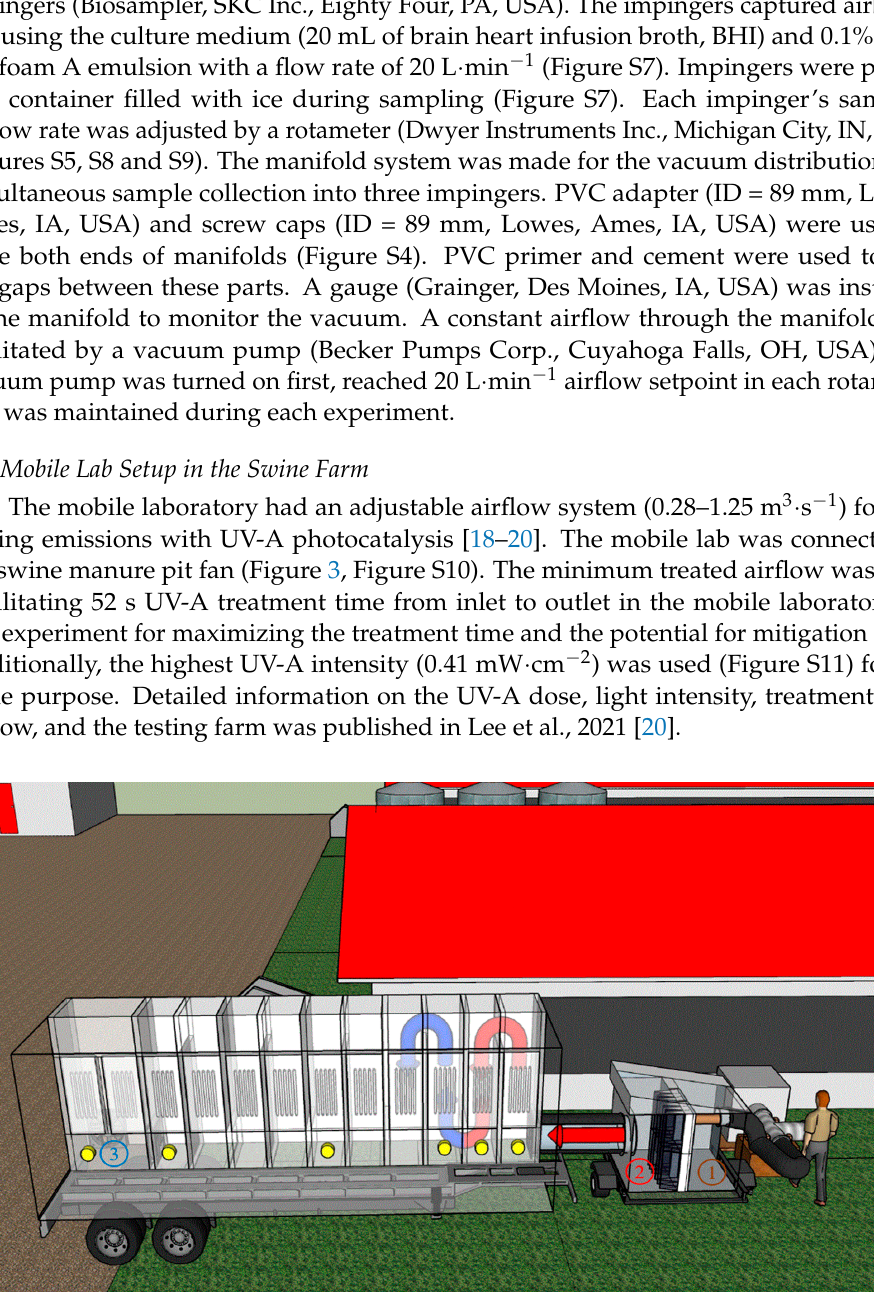
Figure 3. Schematic of particulate matter and airborne pathogens sampling ports (yellow) in the UV mobile laboratory and filtration system. Three ‐ dimensional ‘arrows’ represent free airflow. (1) Brown ‘arrow’: Exhaust air from swine barn fan; (2) Red ‘arrow’: Inlet air with reduced particle matter load after MERV filtration; (3) Blue ‘arrow’: Treated air with UV ‐ A photocatalysis.